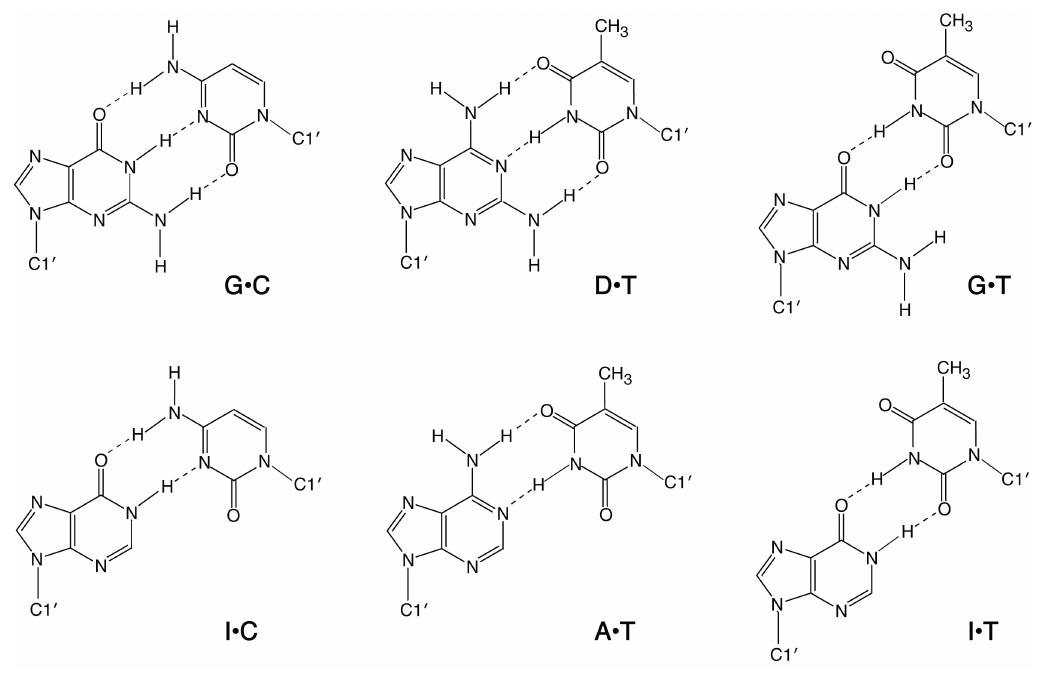
Figure 1. Base-paired structures of X•Y in the DNA duplexes used in this study. Dotted lines represent hydrogen bonds, and C1' represents the anomeric carbon of the sugar moiety of